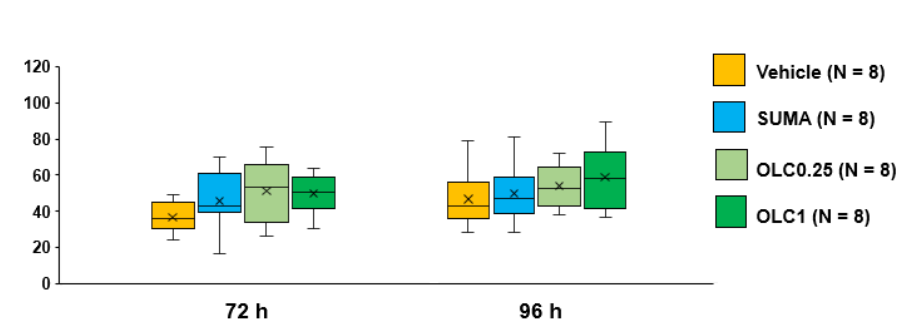
Figure 6. Ambulatory time in the dark zone in each group. Data are plotted in the box-and-whisker box. The ordinate represents the sum of ambulatory time spent in the dark zone during the evaluation period. Statistical analysis was performed using the two-way repeated measures ANOVA with effective matching to evaluate the effects of time and pharmacological interventions. Multiple comparisons were made by Sidak’s test for identical groups between 72 h and 96 h and by Dunnett’s test for different groups at the same timepoint. N = 8 in each group. Vehicle: Vehicle group, SUMA: Sumatriptan group, OLC0.25: Olcegepant 0.25 mg group, OLC1: Olcegepant 1 mg group.